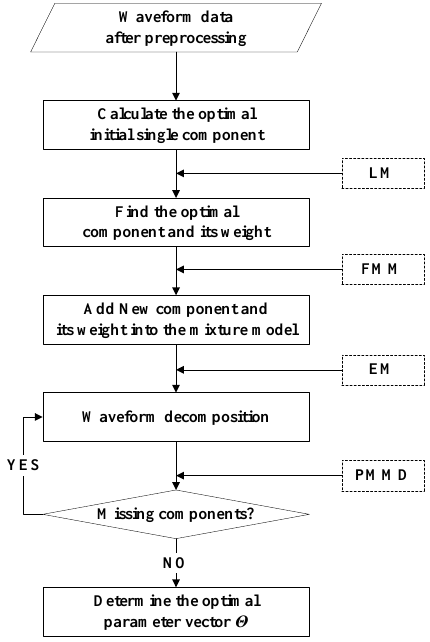
Figure 1. Flow char of the component detection algorithm